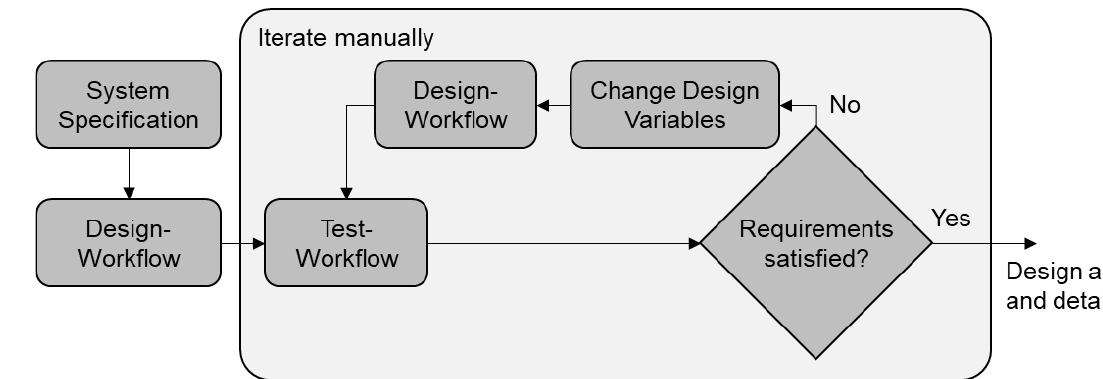
Figure 8. Manual iteration using design and test workflows.